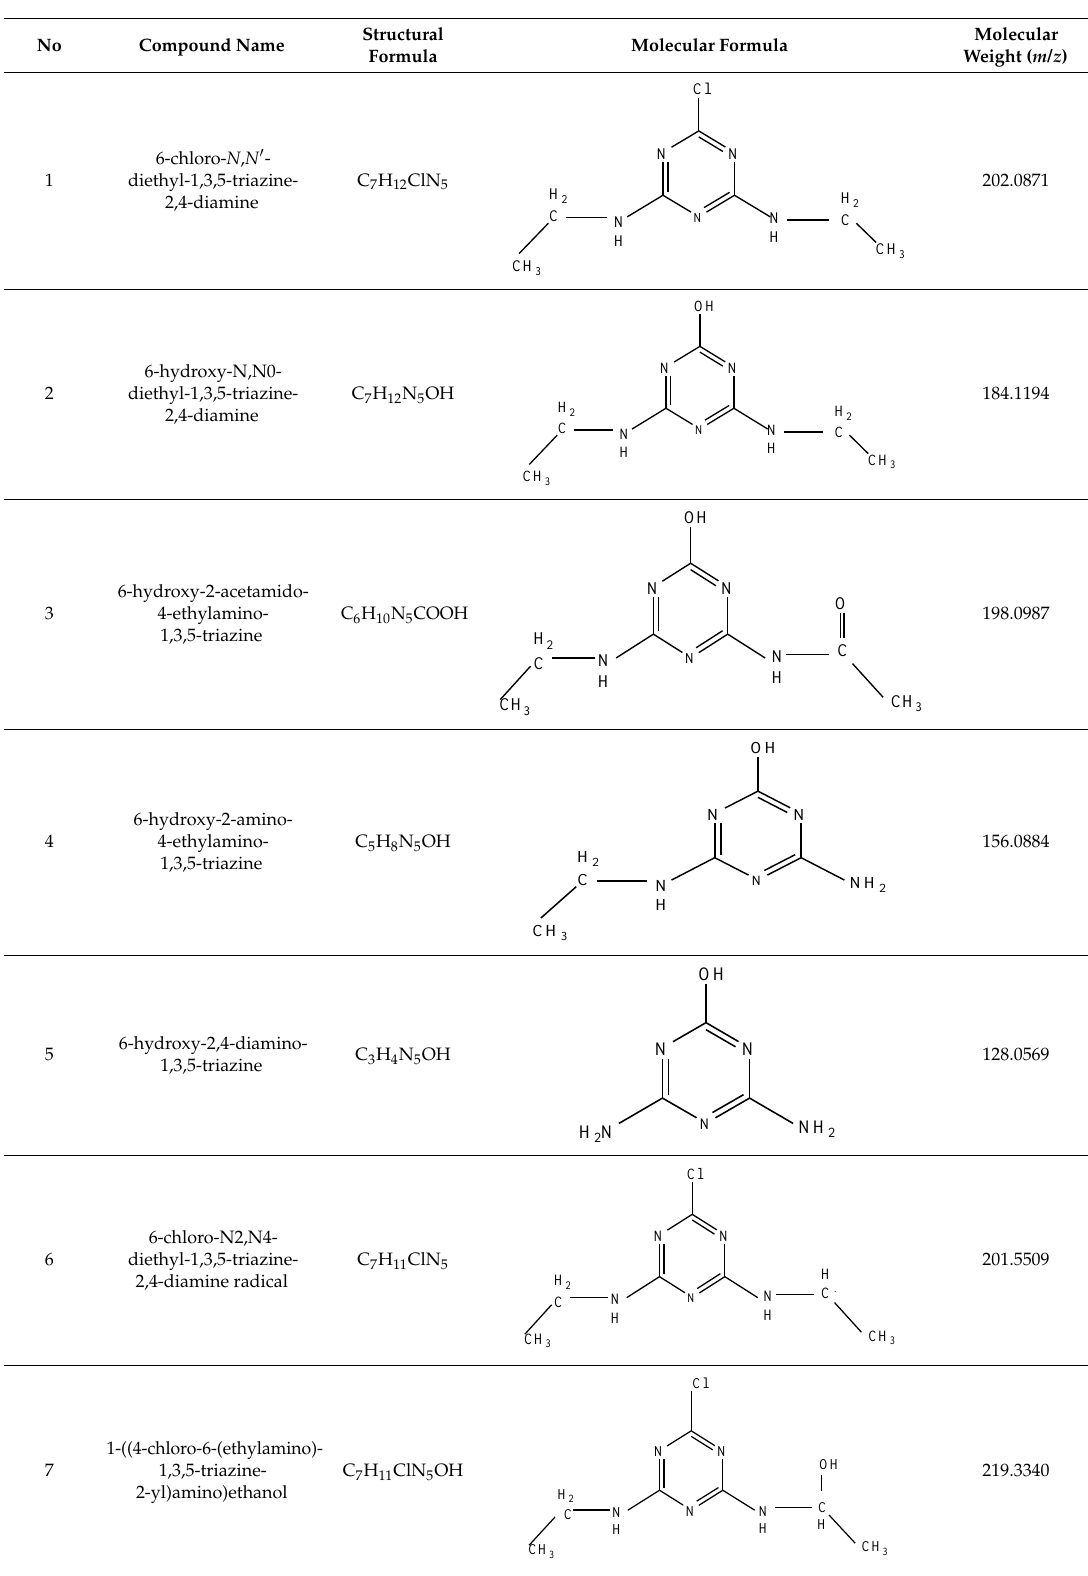
Table 3. Compounds detected during Simazine photocatalytic degradation.